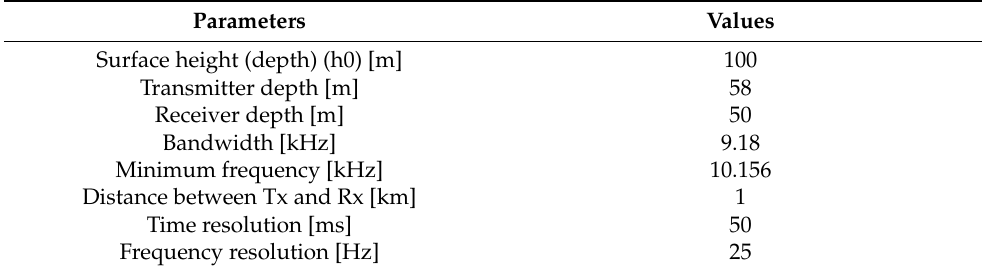
Table 1. Underwater acoustic environment